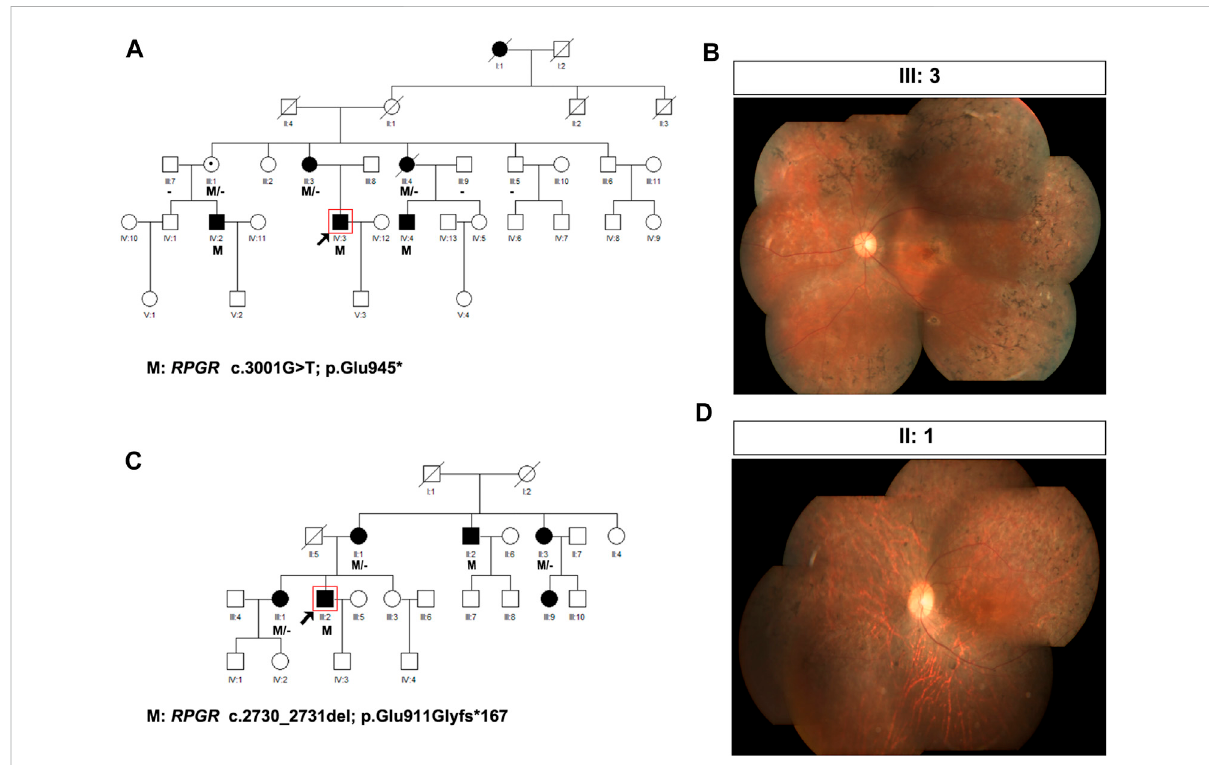
FIGURE 1 Pedigree andimagesoffamiliesP19and P20. (A) Pedigree offamily P19; (B) fundusphotographofthelefteyeofindividualIII:3from familyP19; (C) pedigree of family P20; and (D) fundus photograph of the right eye of individual II:1 from family P20. Black squares (males) and circles (females) representindividualsaffectedwithRP.Dottedcircles(females)representindividualswhoare RPGR mutationcarriersbutwhoarenotaffectedbyRP. Unaffected individuals are not shaded. Black lines indicate deceased individuals The arrow marks the